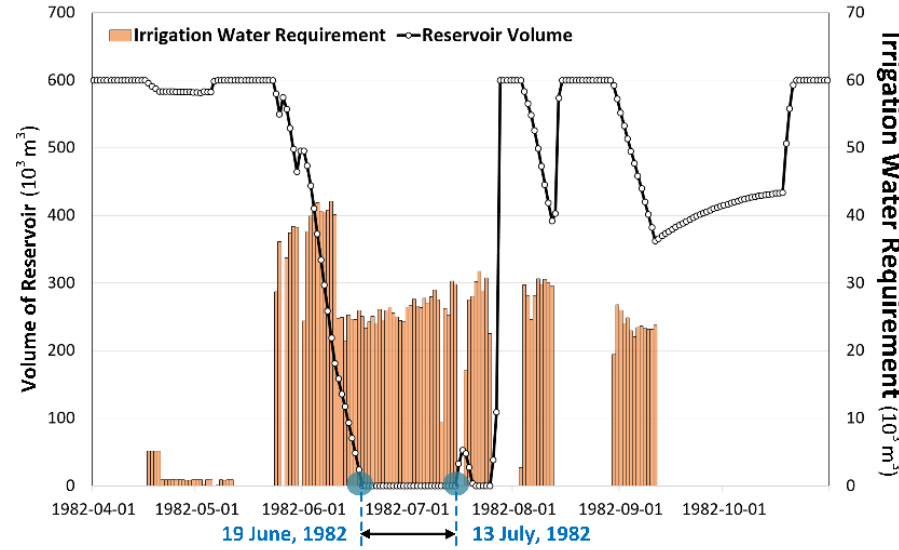
Figure 7. Temporal patterns in the irrigation water requirement and the reservoir volume during the irrigation period in 1982 as determined by the drought year: Res. A.